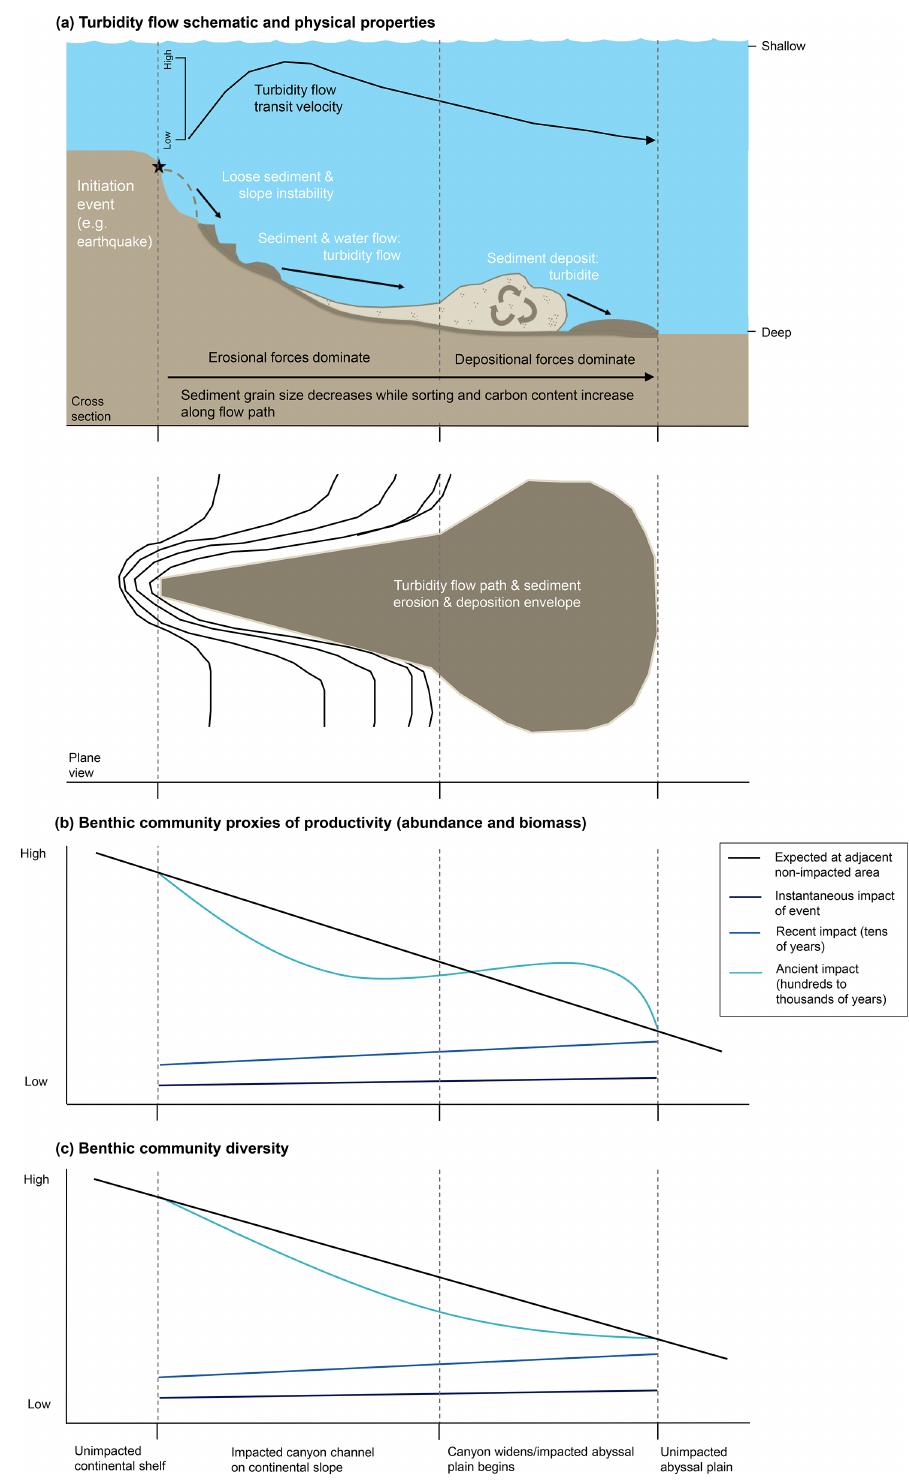
Figure 1. (a) Generalized schematic of a large, single-flow, earthquake-triggered turbidity flow within a continental slope canyon with environmental variables at the moment of the event (adapted from NOAA; Talling et al., 2013, 2014; Stetten et al., 2015; Heerema et al., 2020). (b, c) Our hypothesized response of the benthic community productivity (abundance and biomass) and diversity along the turbidity flow path at three time points (the instantaneous moment of the event, tens of years after, and hundreds to thousands of years